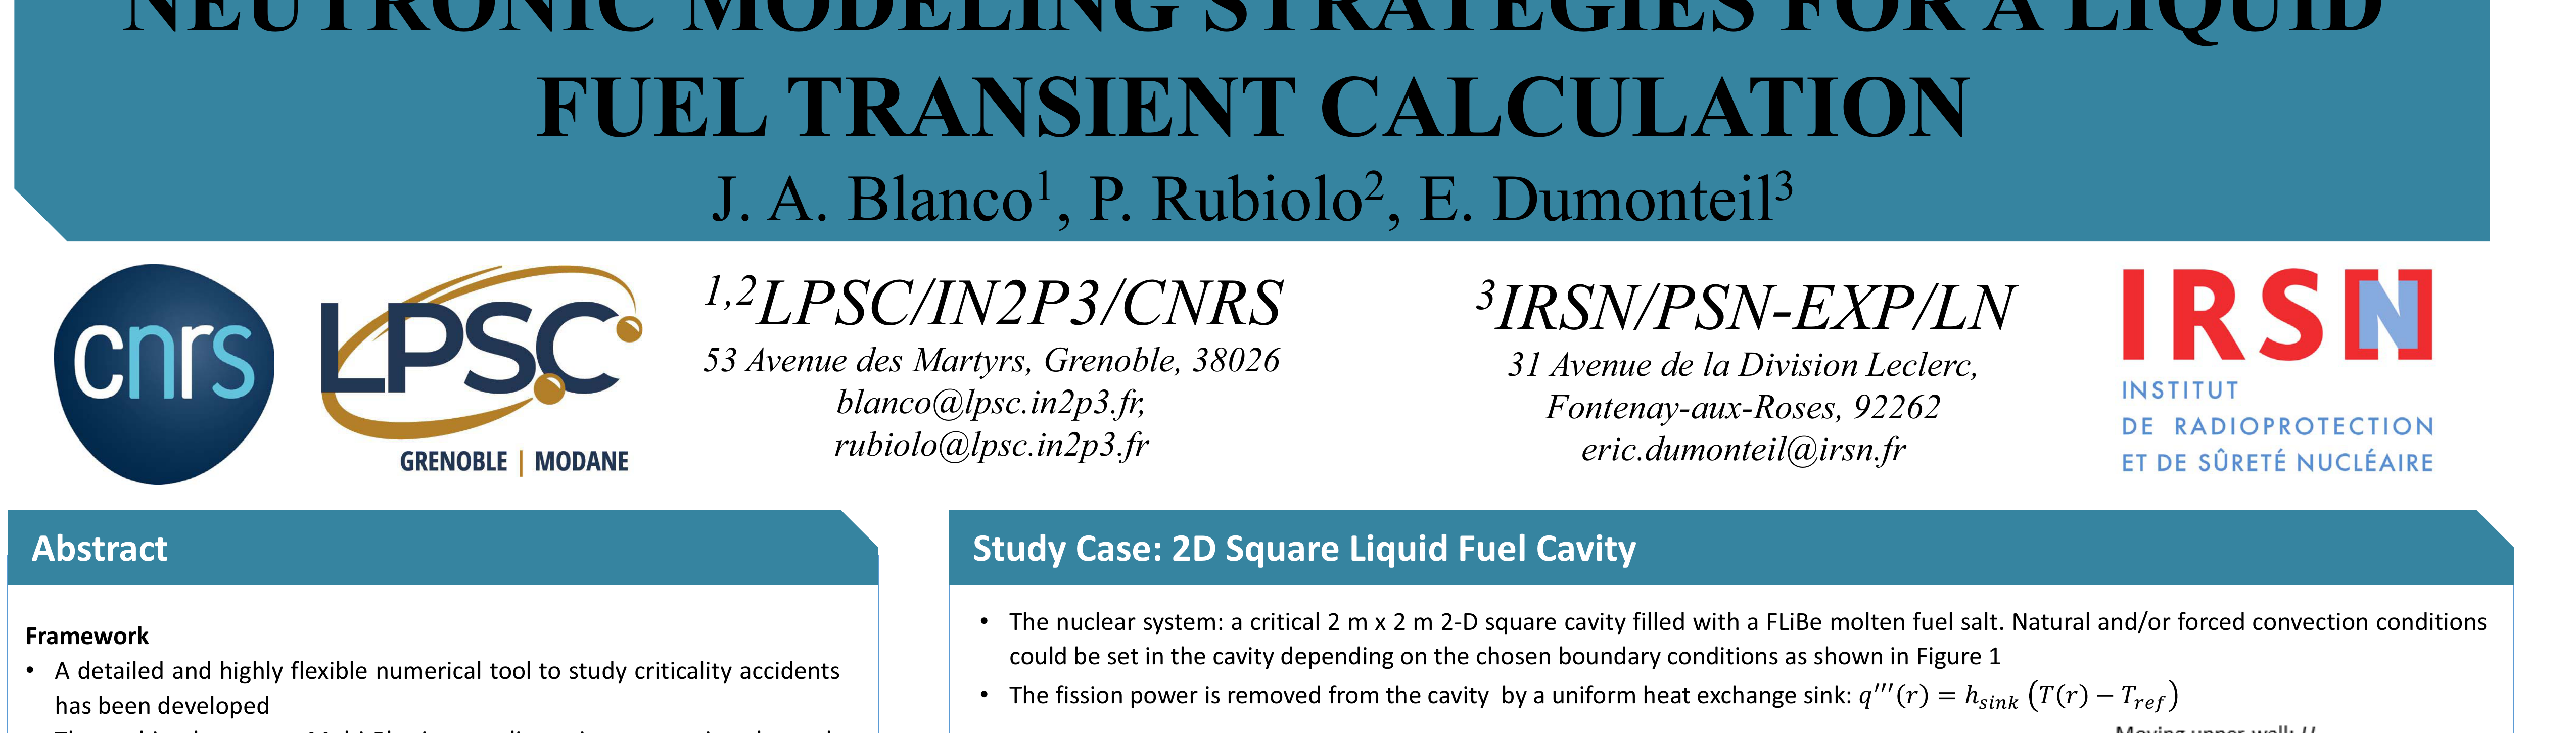
Figure 1. CNRS multi-physics benchmark: lid-driven Cavity Scheme.